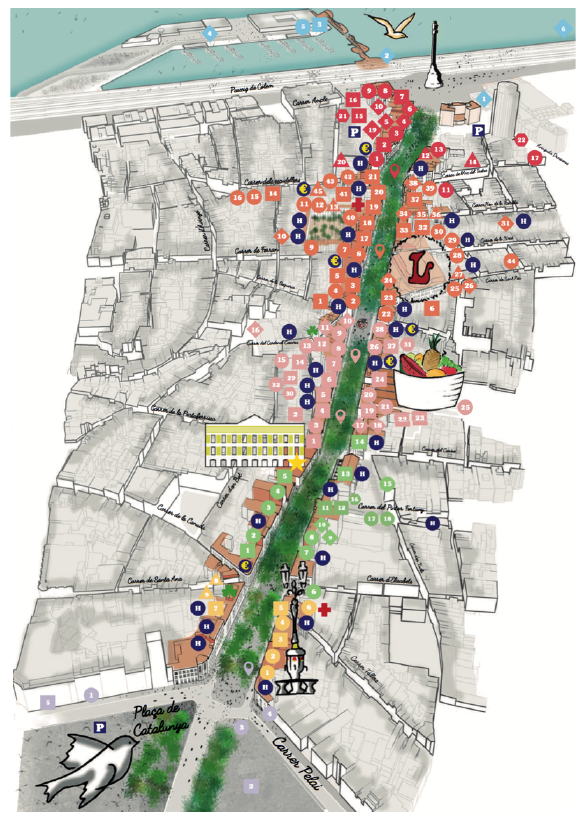
Figure 9. Watercolour drawing in a Rambla guide with its shops. Source: Amics de la Rambla Association (ARA,